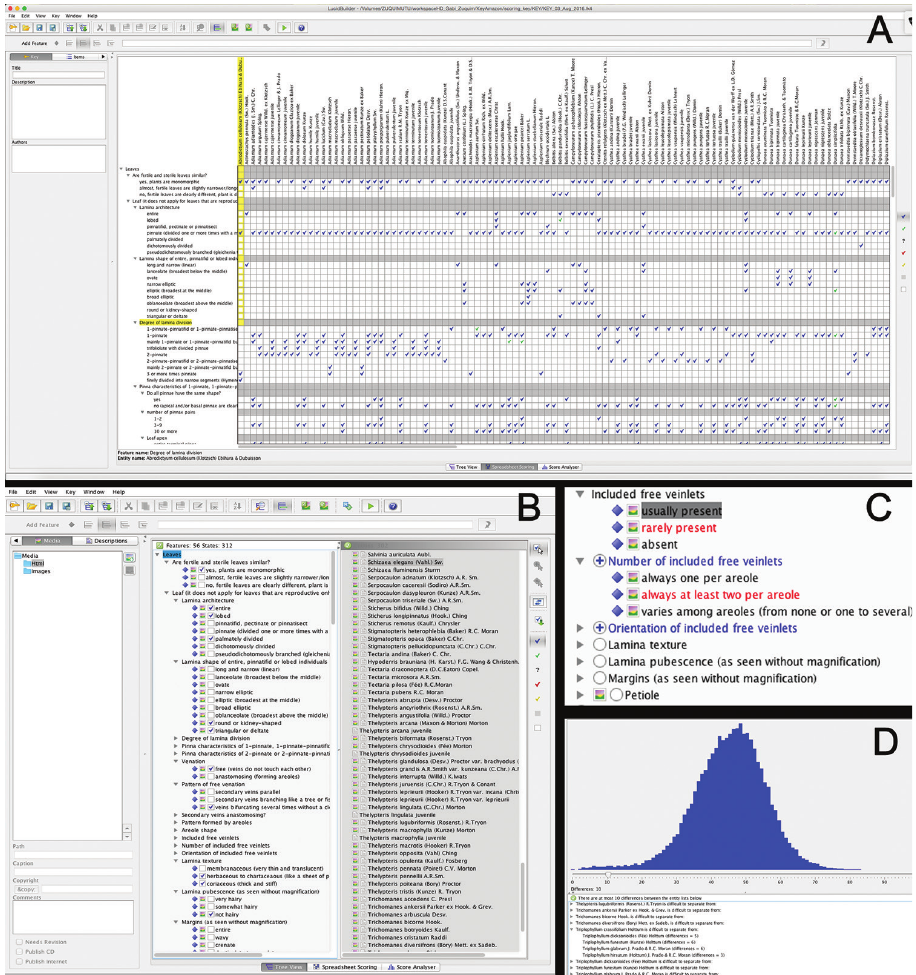
Figure 2. Structure of the key under development in LucidBuilder. Screenshots of the key been devel- oped in Lucid Builder V 3.5. A spreadsheet scoring table view B tree view mode of the scores for a